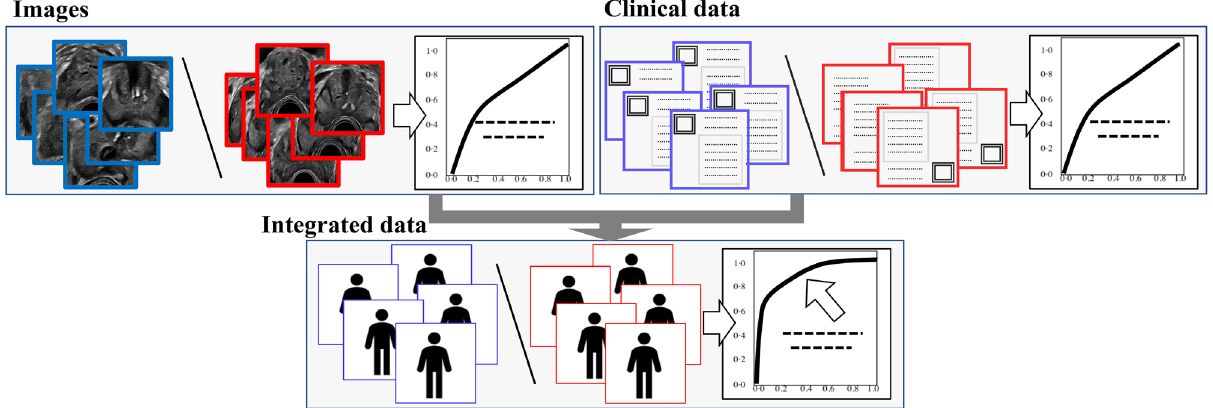
Figure 1. Flowchart of our study. Deep learning analysis for ultrasound images (upper left images), clinical data (upper right images), and integrated data (lower images). Total Cancer